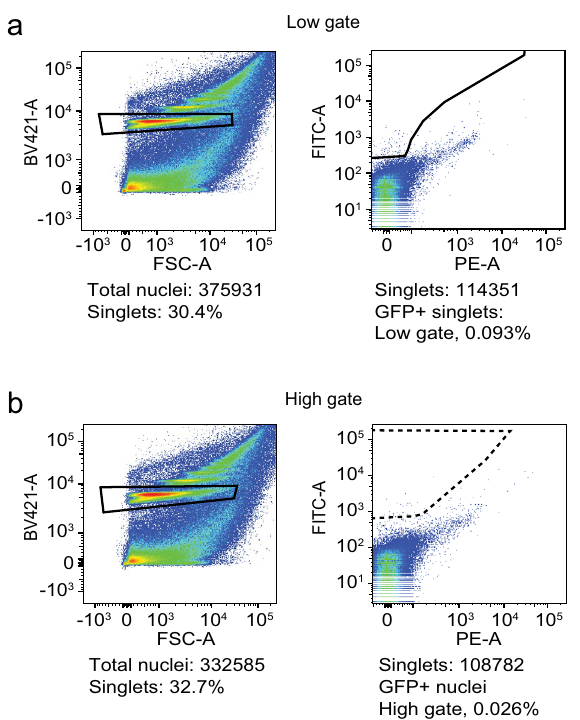
Figure 3. Flow cytometry shows high specificity and few false positives. Nuclei were isolated from w* Berlin heads (GFP-negative) and analyzed by flow cytometry. ( a ) Representative dot plots of nuclei analyzed using the low gate. Nuclei were identified by DAPI staining (Y-axis) and forward light scatter (X-axis, left). The box indicates the sorted DAPI+ singlet nuclei, which were then analyzed for green fluorescence (Y-axis) and the red PE-A channel (X-axis, right), which allowed the best separation of GFP populations. The nuclei were sorted at the low gate (solid trapezoid box). 0.093% of input singlets were GFP false-positives (and 0.024% when applying the high gate in this sort). ( b ) Representative dot plots of nuclei analyzed using the high gate. Nuclei were isolated as in ( a ) and sorted for green fluorescence at the high gate (stippled trapezoid box, right). 0.026% of input singlets were GFP false-positives (and 0.10% when applying the low gate in this